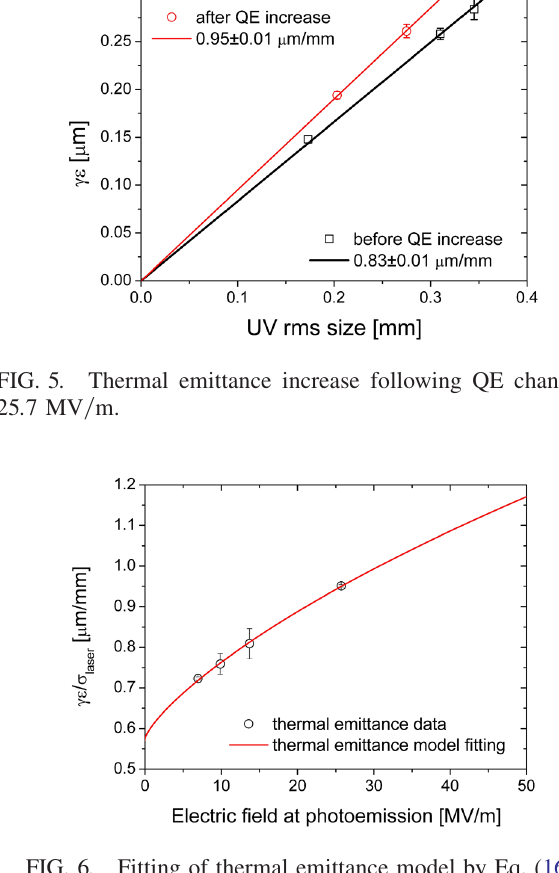
FIG. 6. Fitting of thermal emittance model by Eq.